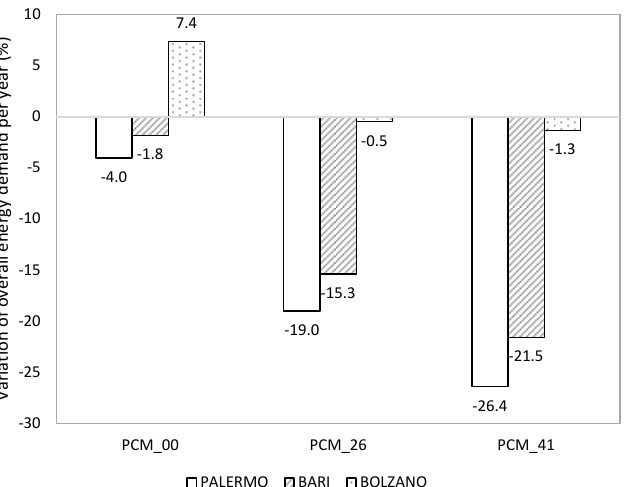
Figure 18. Percent variation of annual energy need for heating plus cooling respect to Reference.